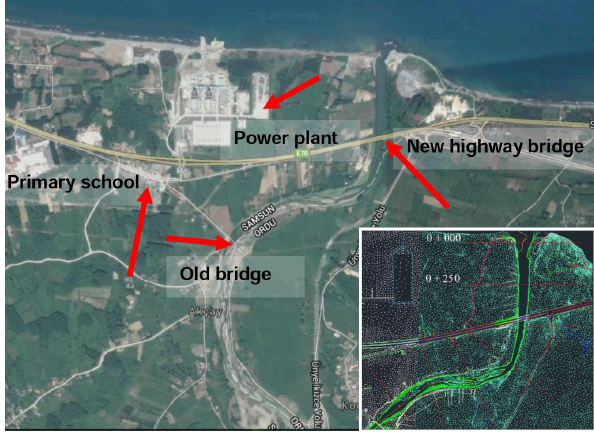
Figure 2. A detailed view of Akçay Creek in Ikizce watershed.